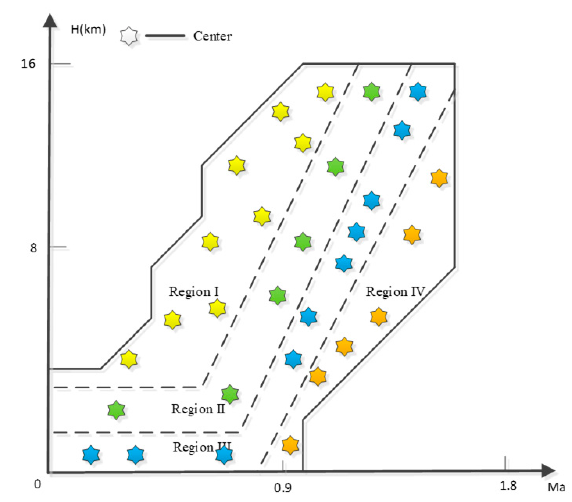
Figure 5. Cluster centers of sub-regions.